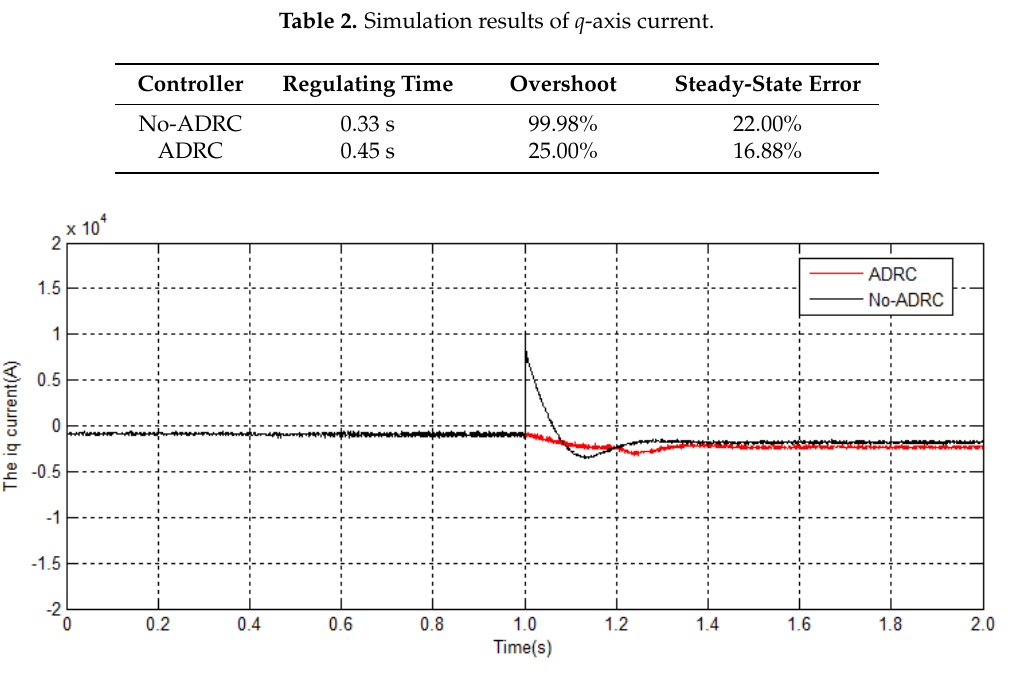
Table 3. Simulation results of electromagnetic torque.